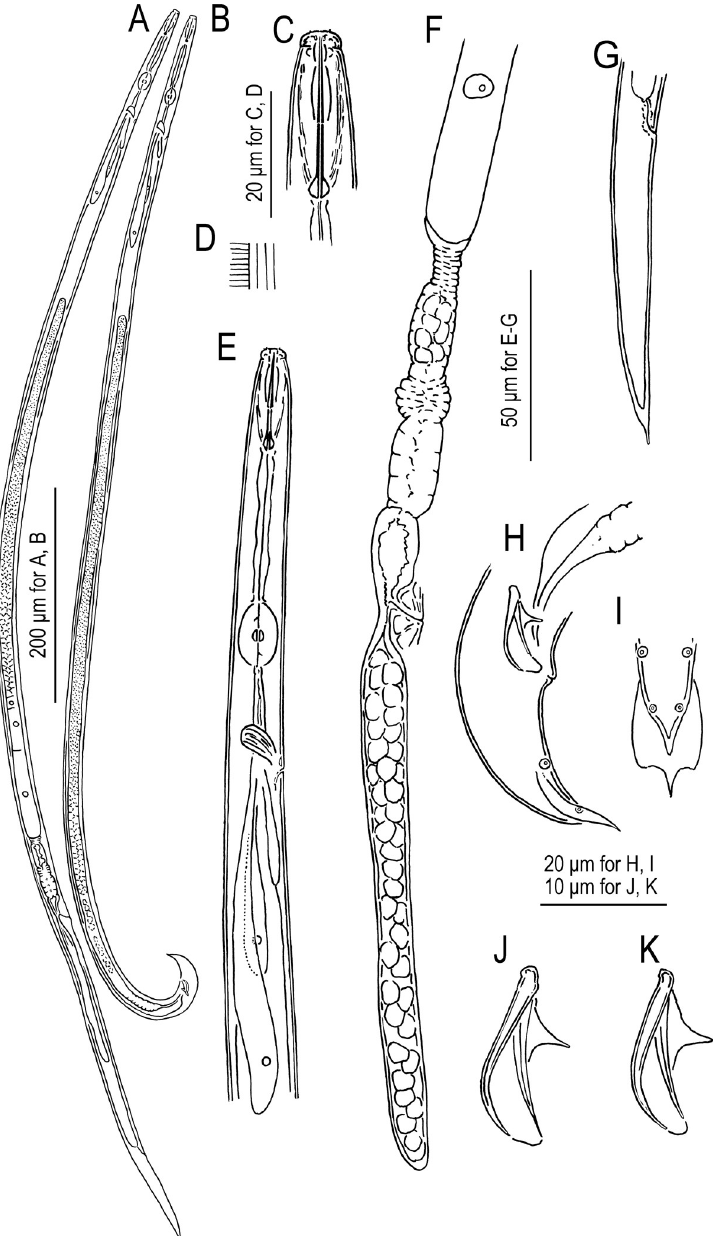
Fig 3. Morphological drawings for adult Bursaphelenchus suri n. sp. A: Female; B: Male; C: Lip and stylet region of male; D: Body surface of male showing lateral field and annulations; E: Head to pharyngeal region of male; F: Posterior part of female gonad; G: Female tail; H: Male tail; I: Male tail tip; J, K: Male spicule. All subfigures are in the right lateral view except for H (ventral view). pharyngeal gland ca 7–10 metacorpal lengths long. Nerve ring at about one stylet length (about 1.5 metacorpal lengths) posterior to metacorpus. Hemizonid about 1.5 stylet length (about 2 metacorpal lengths) posterior to metacorpus. Secretory-excretory pore at immediately posterior or almost same level of hemizonid.